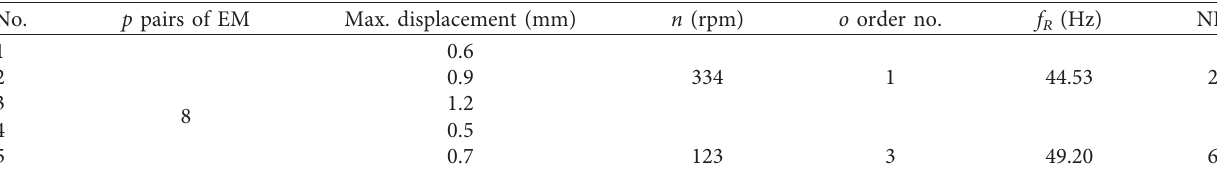
Table 2: Parameters of rotary tests for dry friction damping.